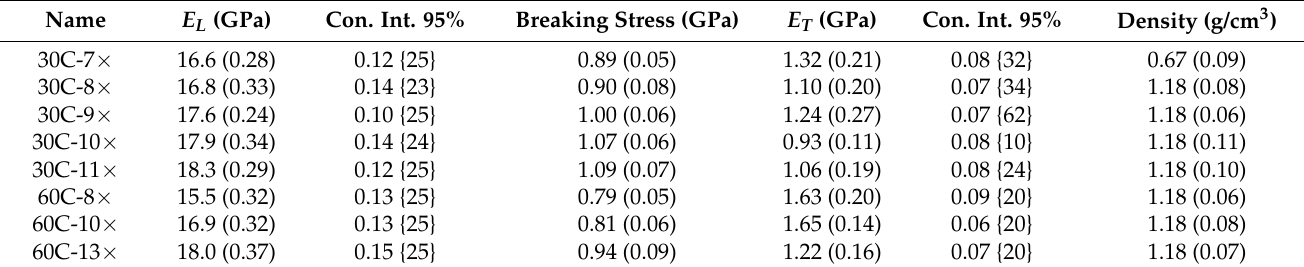
Table 2. The mean E L values, the breaking stress, the mean E T values, and the densities for the WFs and CFs investigated in this study. The E L and density values were measured using a Favimat. Standard deviations are indicated in the round brackets. The confidence intervals (95% confidence) have been provided for the modulus values. The number of measurements is indicated after each confidence interval in curly brackets.